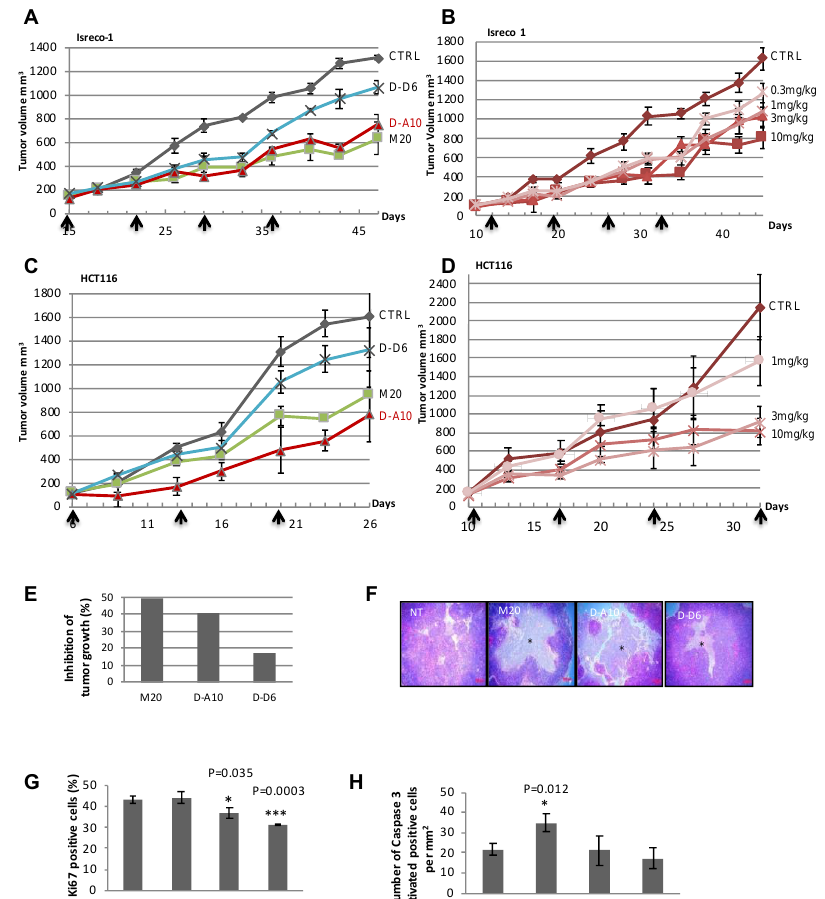
Figure 2. Targeting eK8 using the D-A10 MAb induces apoptosis in vivo. ( A , B ) Effect of M20 antibody or of D-A10 and D-D6 MAbs ( A ) or dose-dependent effect of D-A10 MAb ( B ) on Isreco-1 tumor growth. Mouse model of xenograft tumor (three mice per group ± SEM). The average tumor volume of each group of mice is represented on the graph. Antibody intraperitoneal injections performed at the opposite site of the tumor are indicated with black arrows: ( A )—days 15, 22, 29, and 36; ( B )—days 12, 19, 26, and 33. ( C , D ) Effect of M20 antibody or of D-A10 and D-D6 MAbs ( C ) or dose-dependent effect of D-A10 MAb ( D ) on HCT116 tumor growth. Mouse model of xenograft tumor (three mice per group ± SEM). The average tumor volume of each group of mice is represented on the graph. Antibody injections are indicated with black arrows: ( C )—days 6, 13, and 20; ( D )—days 10, 17, 24, and 32. ( E – H ) Analysis of the in vivo experiment presented in ( A ). ( E ) Histogram quantifying tumor growth at day 40). Percentage of tumor growth inhibition compared to non-treated mice. ( F ) Immunohistochemical (IHC) analysis by hematoxylin and eosin staining of tumors at the end of the 53-day experimental time course) treated or not with the M20 antibody or with the D-A10 and D-D6 MAbs. ( G , H ) Histolab software analysis of the tissue section for quantification of the number of Ki67-positive cells compared to total cells (%) (n = 3) ( G ). Student’s t -test: * p < 0.05; *** p < 0.001. Histolab software analysis of the tissue section for quantification of the number of Casp3A-positive cells (per mm 2 , n = 3) ( H ). Student’s t -test: * p < 0.05.